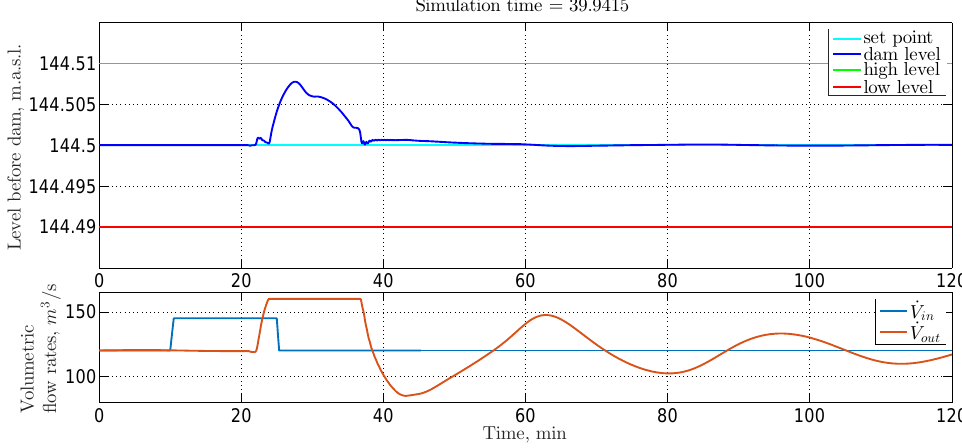
Figure 5: The results of simulation with PI controller ( T s = 5 , K p = − 2850 and T i = 450).